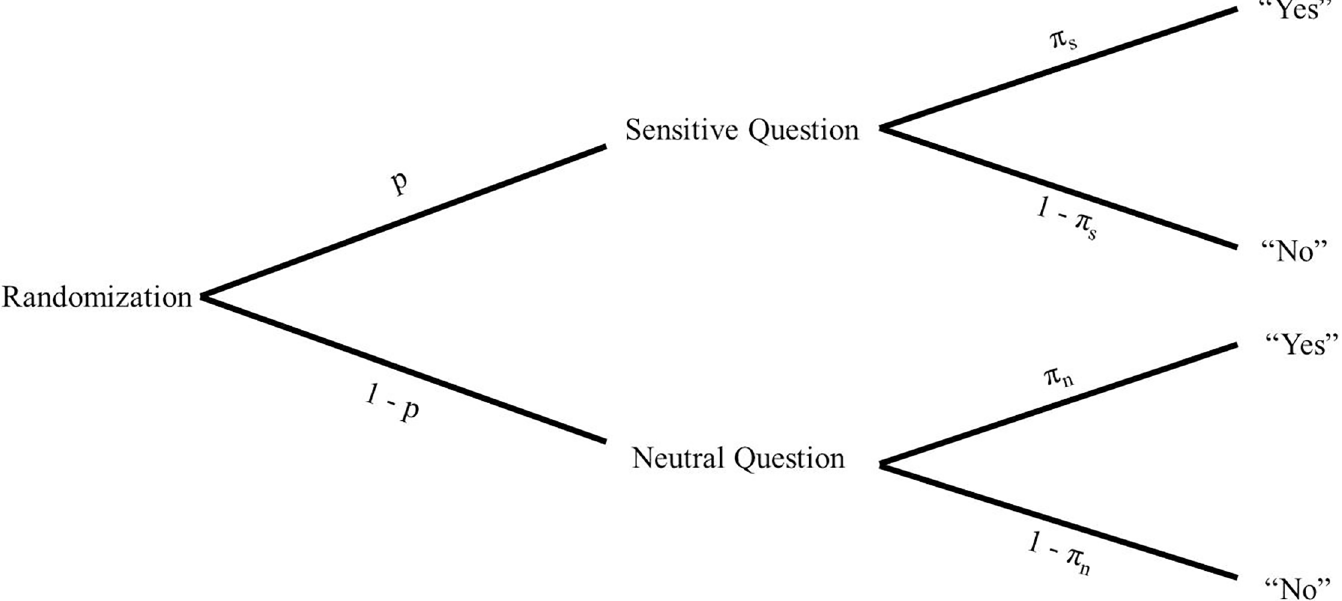
Fig 1. Tree diagram of the unrelated question method (UQM). p denotes the probability of receiving the sensitive question; π neutral question with “yes”; π s denotes the prevalence for the sensitive